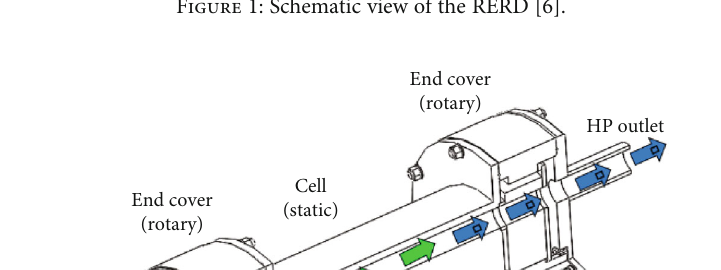
Figure 1: Schematic view of the RERD [6].